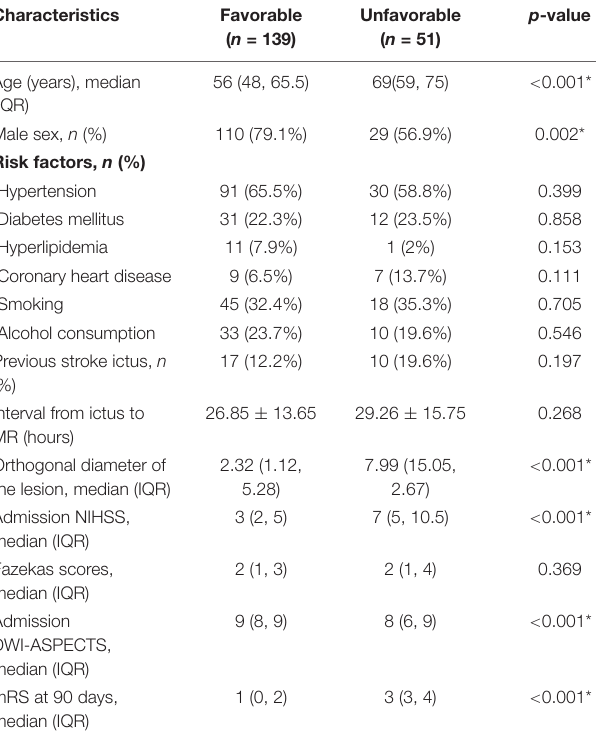
unfavorable outcome.